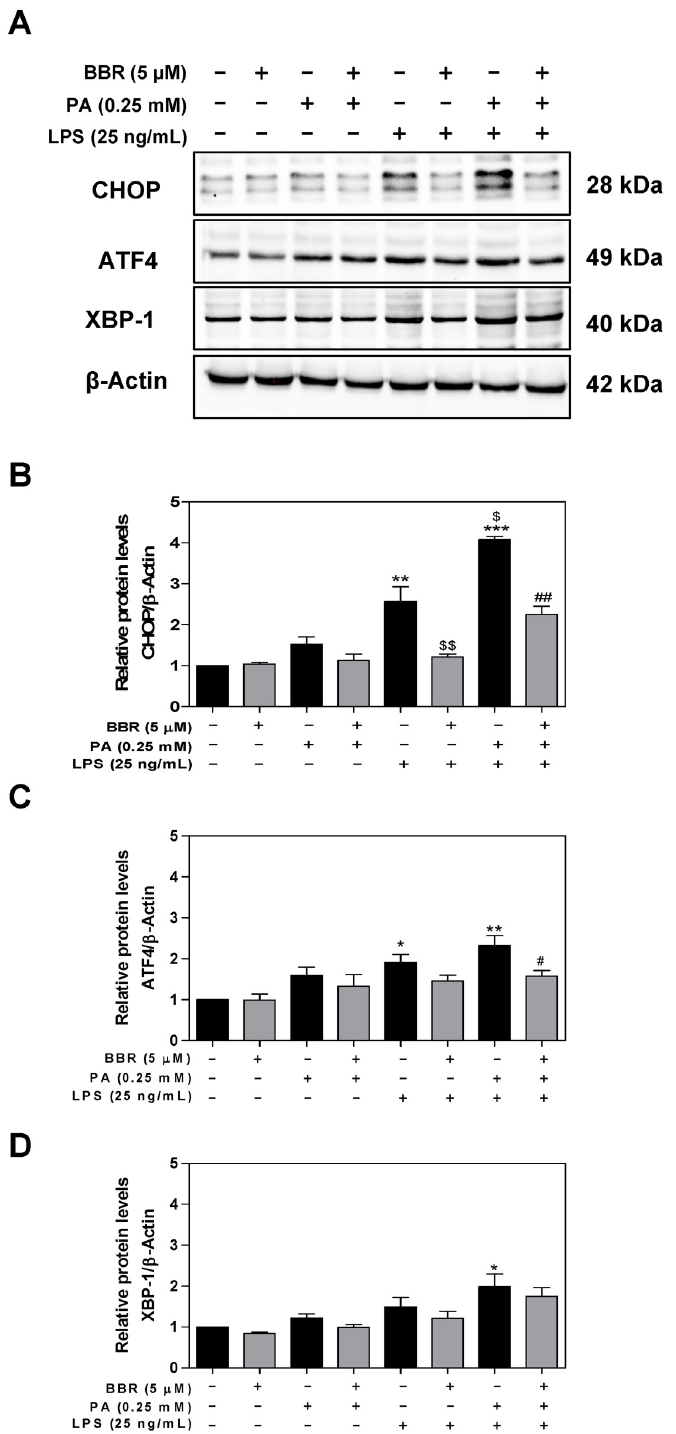
Fig 4. Effect of BBR on PA and LPS-induced protein expression of the UPR genes in RAW264.7 macrophages. RAW264.7 cells were pre-treated with BBR (5 μ M) for 1 h, then treated with PA (0.25mM) or LPS (25 ng/mL) or both for 6 h. Total cell lysates were prepared for Western blot analysis as described under Materials and Methods. β -Actin was used as the loading control. Values are mean ± S.E. of three independent experiments. Statistical significance relative to control, � p < 0.05, �� p < 0.01; relative to PA+LPS, # p < 0.05. A . Representative immunoblots of CHOP, ATF4, XBP-1s, and β -Actin; B . The relative protein levels of CHOP; C . The relative protein levels of ATF4; D . The relative protein levels of